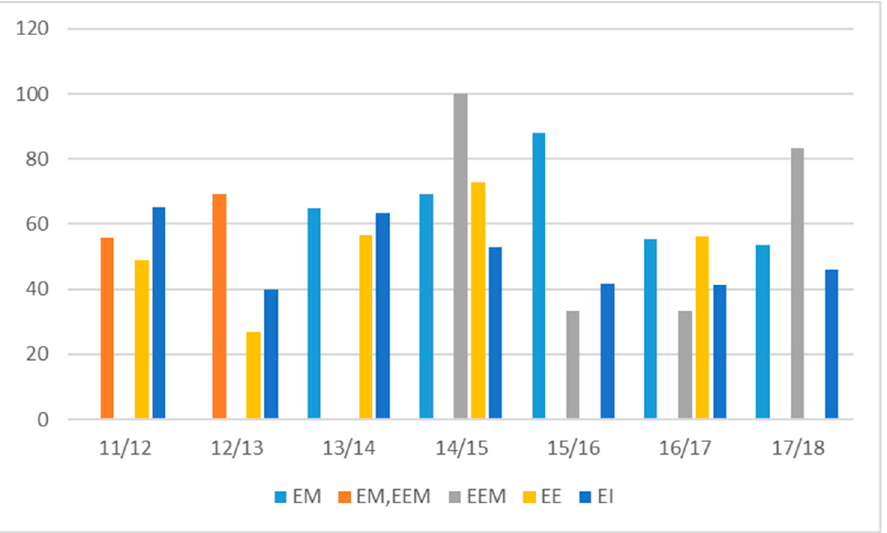
Figure 6. Pass rate distribution for the 1st semester of the academic years 2015/2016 to 2016/2017 and all undergraduate degrees in ISEC.